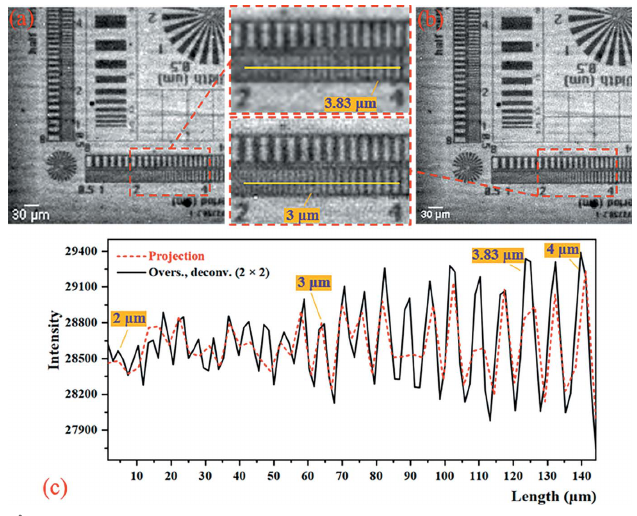
Figure 8 Results of the 2 (cid:2) 2 mode SRX experiment. ( a ) The projection (pixel size: 2.94 m m (cid:2) 2.94 m m; pixel number: 148 (cid:2) 148). ( b ) The oversampled image with deconvolution (pixel size: 1.47 m m (cid:2) 1.47 m m; pixel number: 296 (cid:2) 296). Panels ( a ) and ( b ) are only part of the image to show the details more clearly. ( c ) The intensity profiles at the yellow line (line- width between 2 m m and 4 m m).